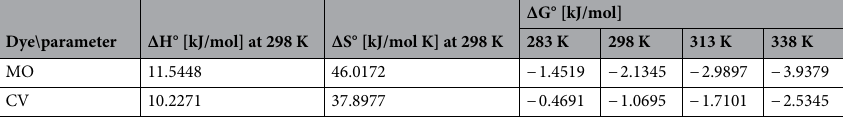
Table 3. Thermodynamic parameters for CO 2 adsorption onto Fe 3 O 4 @inulin nanocomposite.